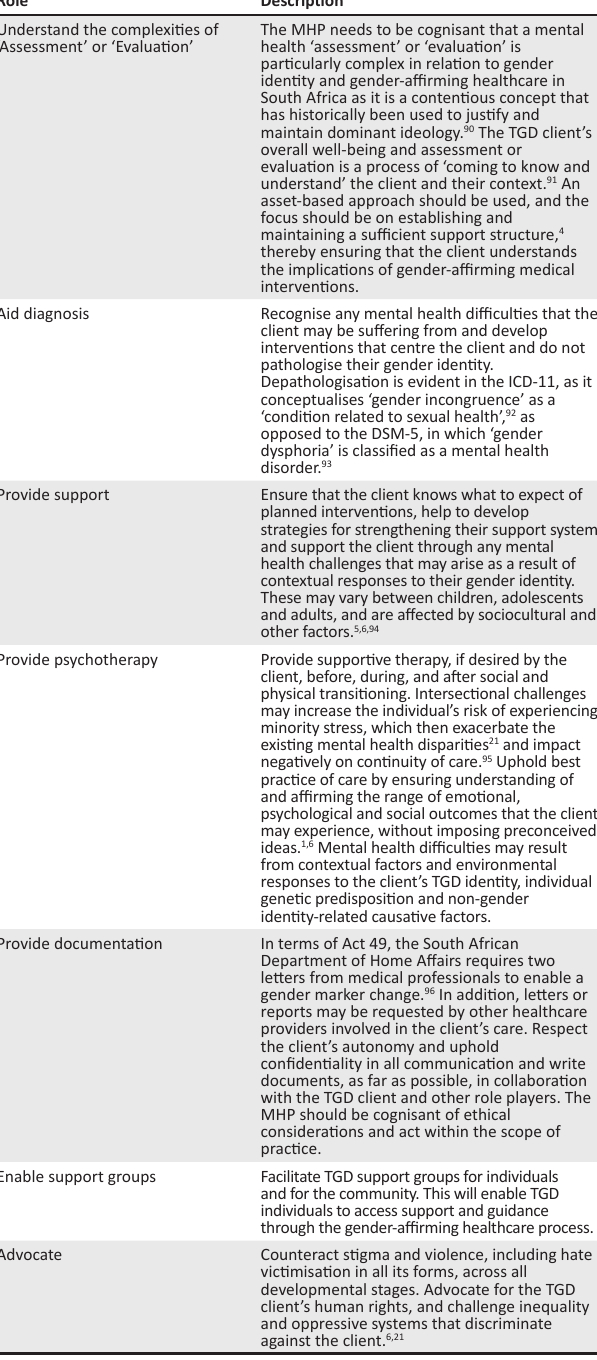
TABLE 3: The role of the mental healthcare provider.